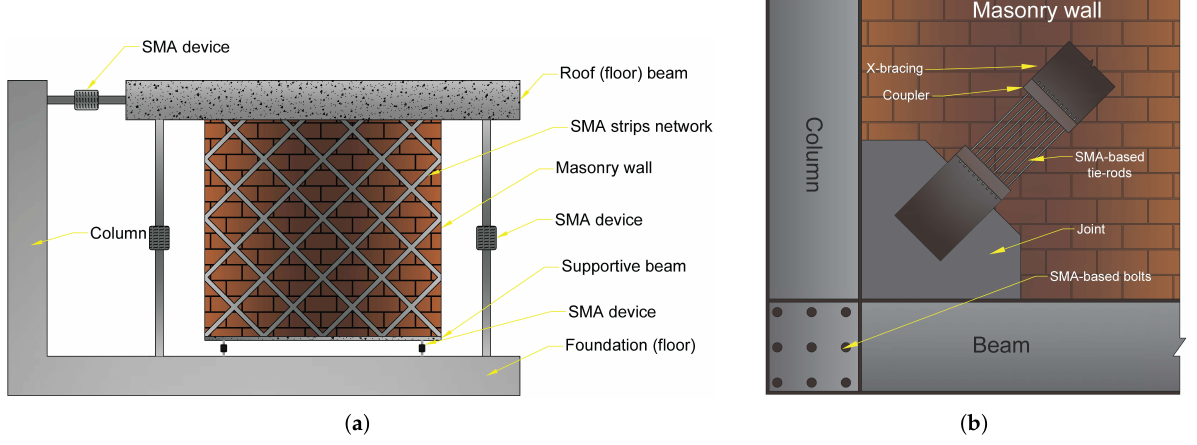
Figure 17. ( a ) Schematic of a retrofitted masonry wall by the application of SMA devices; ( b ) retrofitting of the beam-column connection and the X-bracing system of the steel frames in masonry